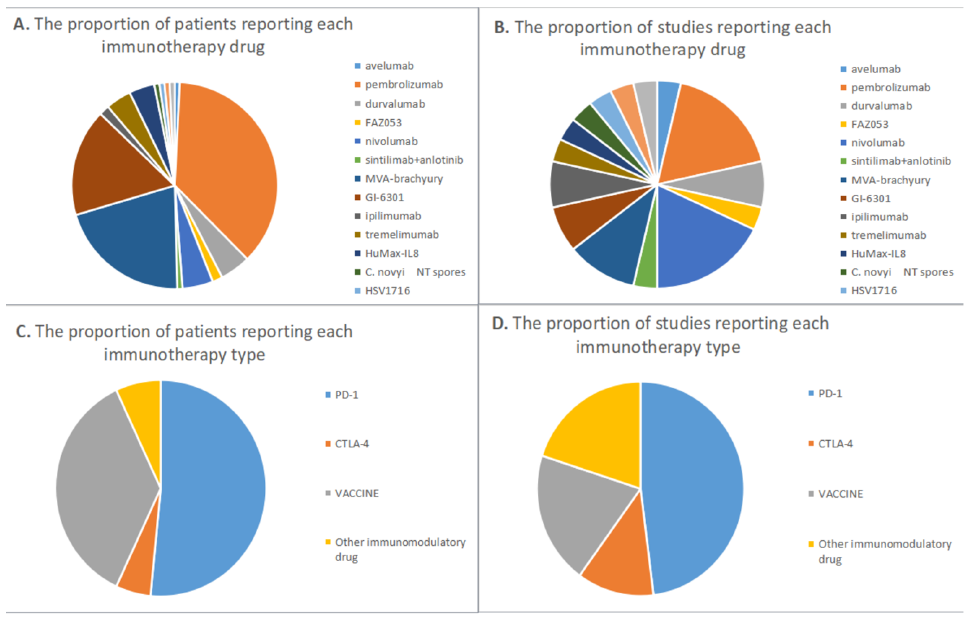
Figure 2. Of the included studies, the proportion of patients (A) and studies (B) reporting each immunotherapy drug, and the propotion of patients (C) and studies (D) reporting each immuno- each immunotherapy drug, and the propotion of patients ( C ) and studies ( D ) reporting each therapy type immunotherapy